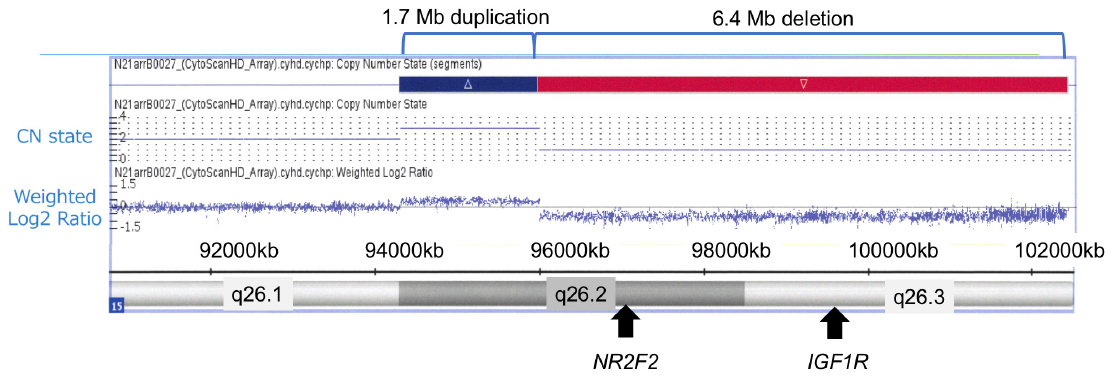
Figure 2. The result of whole-genome single nucleotide polymorphism array analysis. The physical positions correspond to GRCh37/hg19 of the human genome assembly. The arrows indicate the positions of NR2F2 and IGF1R on 15q26.2-26.3, contained in the deletion range.